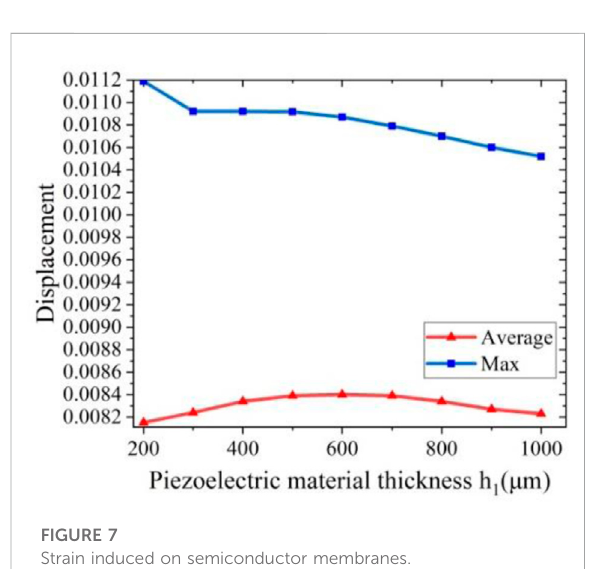
FIGURE 8 Displacement of the semiconductor